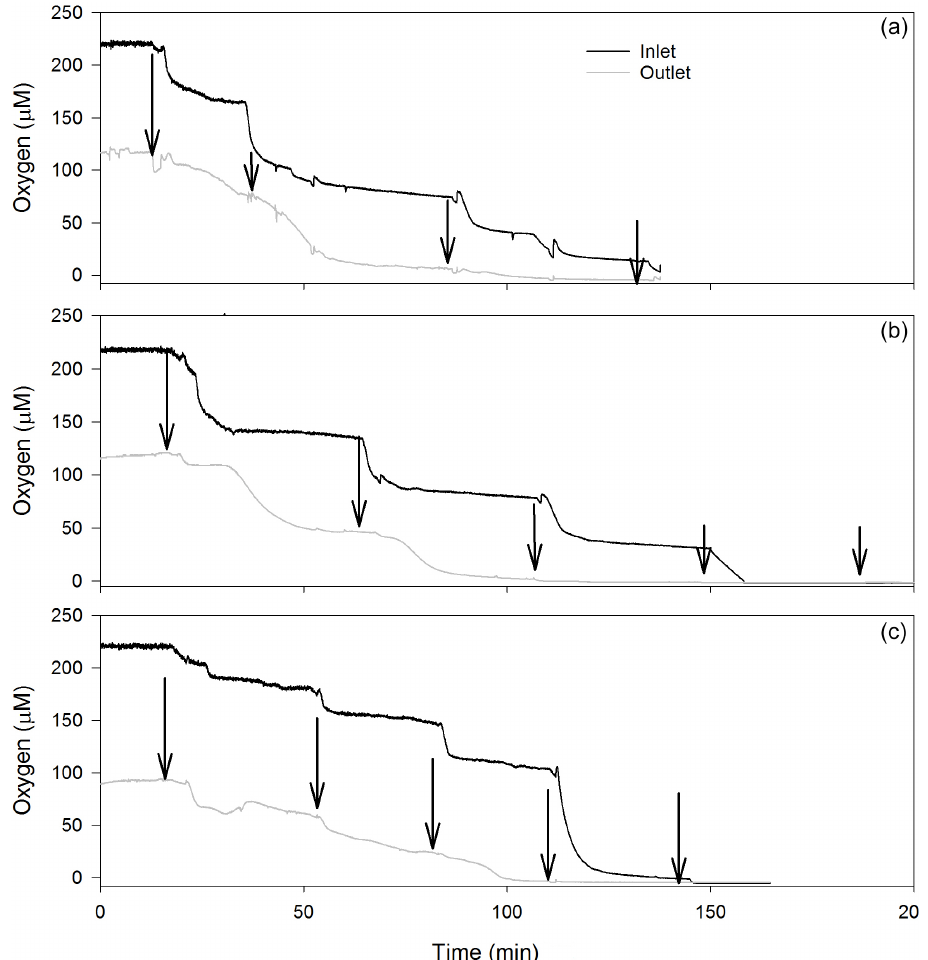
Figure 3. Example time series of oxygen concentrations at the FTR inlet and outlet at sites 1 (a) 2, (b) and 3 (c) . Arrows mark sampling points for 15 N–N 2 ; note 15 NO − tracer was added > 30min before the first sampling point (i.e. before the O 2 trace commences). 3